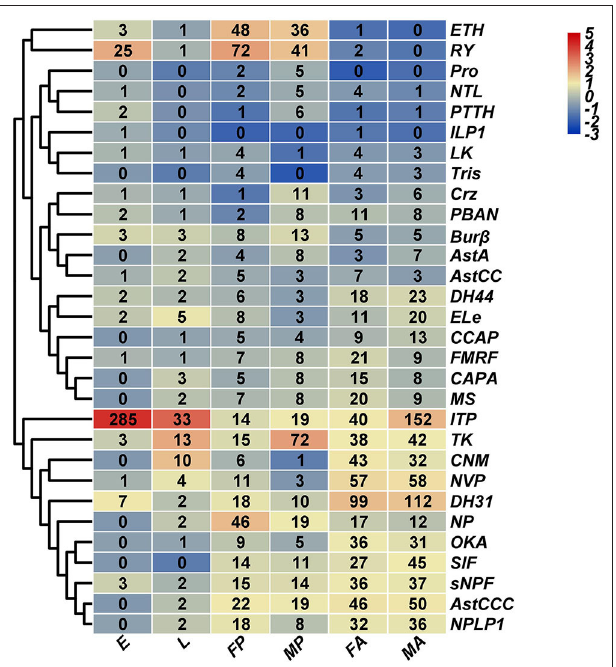
FIGURE 9 | Expression profiles of H. hebetor neuropeptide precursor genes across different developmental stages. Log2 FPKM (fragments per kilobase of transcript per million) values for neuropeptide precursor genes are presented by bar colors where darker red represents higher expression values, and darker navy blue represents lower expression values. FA, female adults; MA, male adults; E, eggs; L, larvae; FP, female pupae; MP, male pupae.